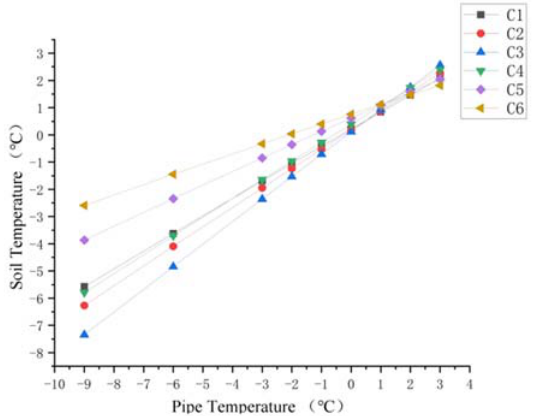
Figure 16. Diagram of soil temperature trend at point C1–C6.